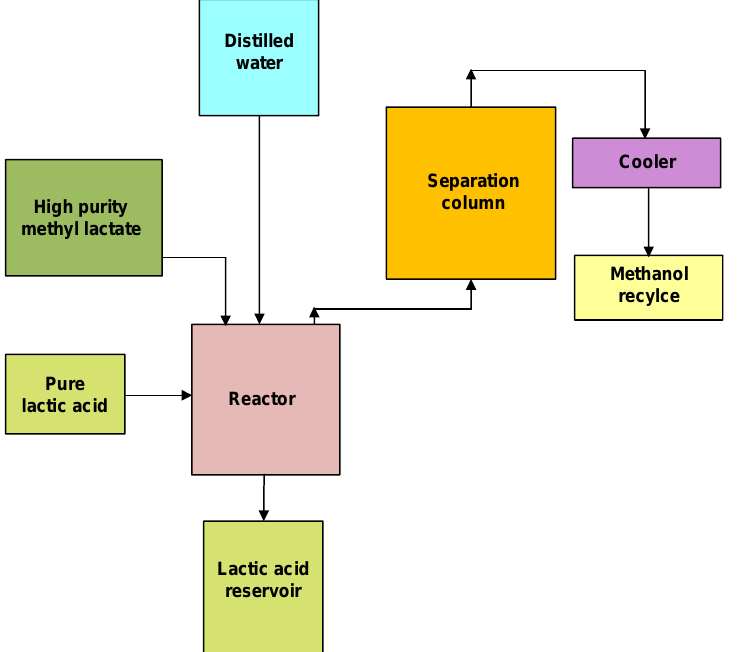
Figure 10. Block diagram for the third step of lactic acid purification involves hydrolysis of methyl lactate and activated carbon treatment (Adapted from Bapat et al. (2014) [189]). During activated carbon treatment, carbon is pretreated with dilute, highly pure L- lactic acid solution in water. This third step results in obtaining high lactic acid purity (99% wt. on a dry basis) at an increased rate of reaction [189,190]. The desired strength of the highly pure L-lactic acid in water is obtained by concentrating pure lactic acid in the evaporator [190]. Methanol, the by-product of the hydrolysis, is recycled back to the bub- ble column (Figure 10), reducing energy consumption and inventory cost. 10.2. Ammonium Lactate Process in Lactic Acid Production The process steps in the ammonium lactate process are like that of the calcium lactate process, except that industrial fermentation is conducted using ammonia liquor. Ammo- nia used as a neutralizing agent in fermentative lactic acid production reduces the acidity of the fermentation broth and reacts with lactate to form ammonium lactate (Equation (6)) [22]. Lactic acid is recovered from ammonium lactate by acidulation with sulphuric acid, followed by ammonium sulfate salt crystallization (Equation (7)). Lactic acid can also be recovered from ammonium lactate by lactic acid esterification using alcohol and back re- covery using pure distilled water or de-ionized water. Sun et al. (2006) [191] reported the extraction of lactic acid from a fermentation broth by esterification and hydrolysis; in the study, butanol reacts with ammonium lactate ob- tained directly from fermentation for 6 h to produce butyl lactate. Sun et al. (2006) [191] further stated that the cation exchange resin used in hydrolysis was modified by replacing sulphuric acid with stannous chloride as the catalyst; neutral ammonium lactate replaced lactic acid as the starting material, and the ammonium lactate was purified. The sequential hydrolysis of purified ammonium lactate in the presence of cation exchange resin in the H + form for 4 h produced 89.7% lactic acid at a purity level of 90% [191]. Lactic acid + Ammonia → Ammonium lactate